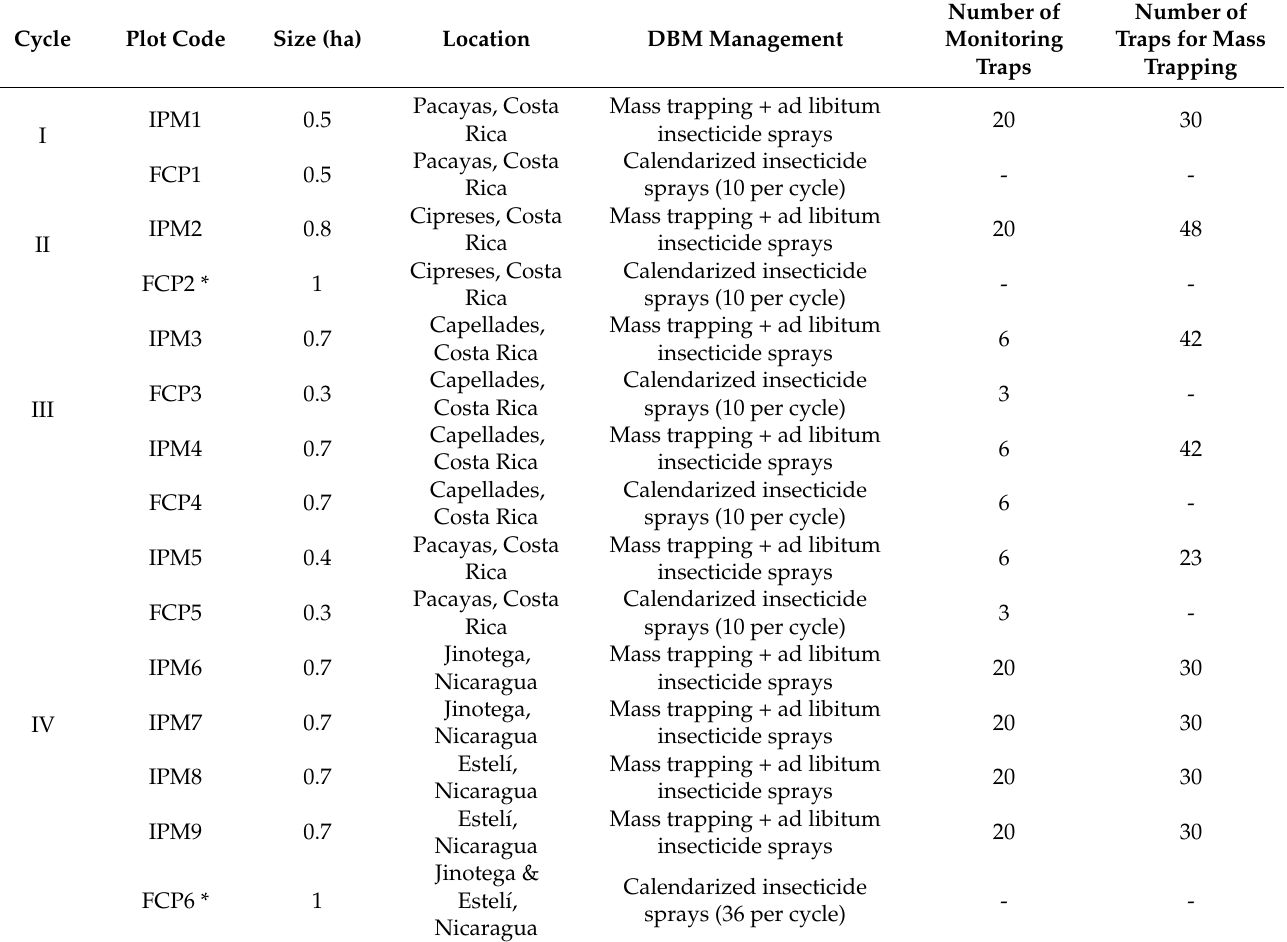
Table 1. Details of crop cycles, farms and management of each case